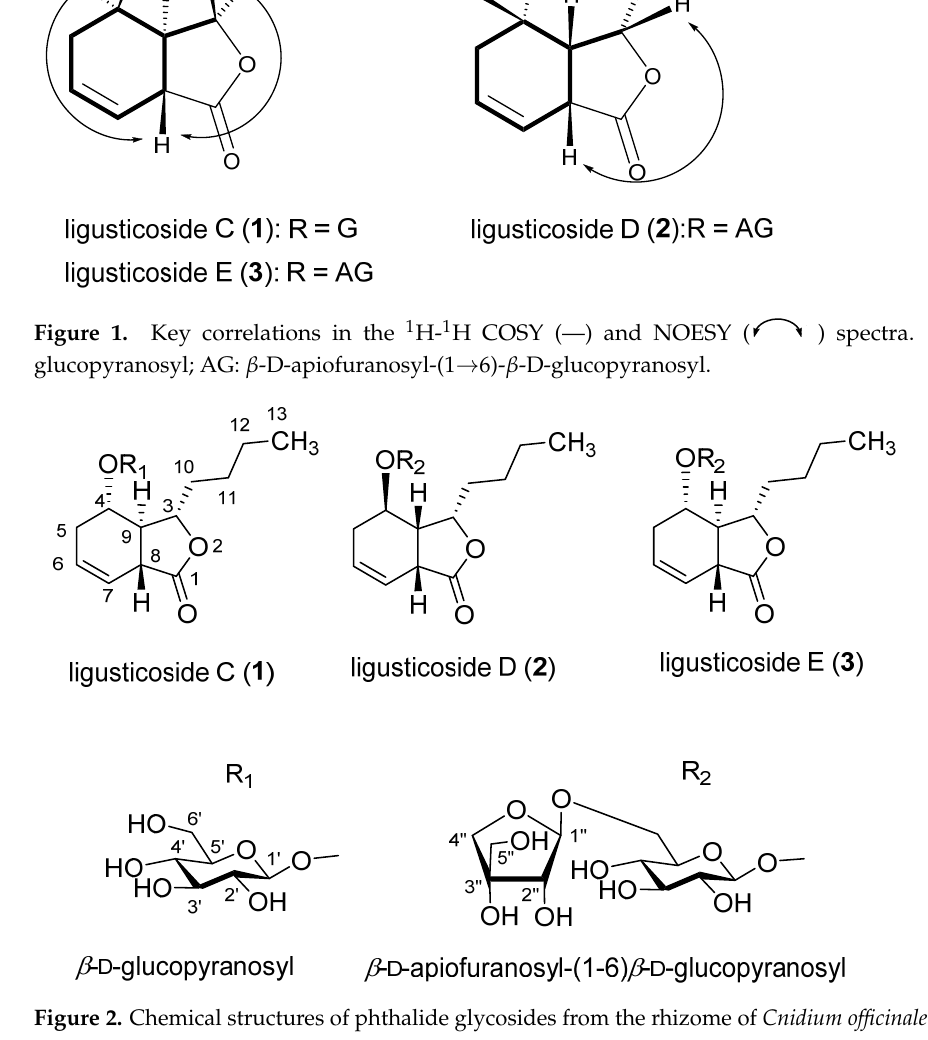
Figure 2. Chemical structures of phthalide glycosides from the rhizome of Cnidium officinale Makino. Compound 3 , a white powder, showed UV absorption at 254 and 365 nm and a deep brown color on TLC upon spraying with 10% sulfuric acid and heating. MF was determined to be C 23 H 36 O 12 (calcd for C 23 H 37 O 12 , 505.2281) from a PM at m/z 505.2283 [M + H] + in HR-ESI-MS. The IR bands showed absorbance bands at 3357 (hydroxyl), 1745 (ester), and 1685 and 1458 cm − 1 (double bond). CMR and PMR (Tables 1 and 2) were almost the same as those of compound 1 with the exception of the additional signals due to one pentose. The signals of the pentose included those of one hemiacetal ( δ H 5.04, d, 2.4, H1”; δ C 111.19, C-1”), one oxygenated quaternary carbon ( δ C 80.62, C-3”), one oxygenated methine ( δ H 3.89, d, 2.4, H-2”; δ C 78.16, C-2”), and two oxygenated methylene carbons ( δ H 3.96, d, 9.6 and δ H 3.76, d, 9.6, H-4”; δ H 3.57, s, H-5”; δ C 75.09, C-4”; δ C 65.57, C-5”). The oxygenated the sugar to be a branched-chain aldopentose, which was identified to be an apiofuranose